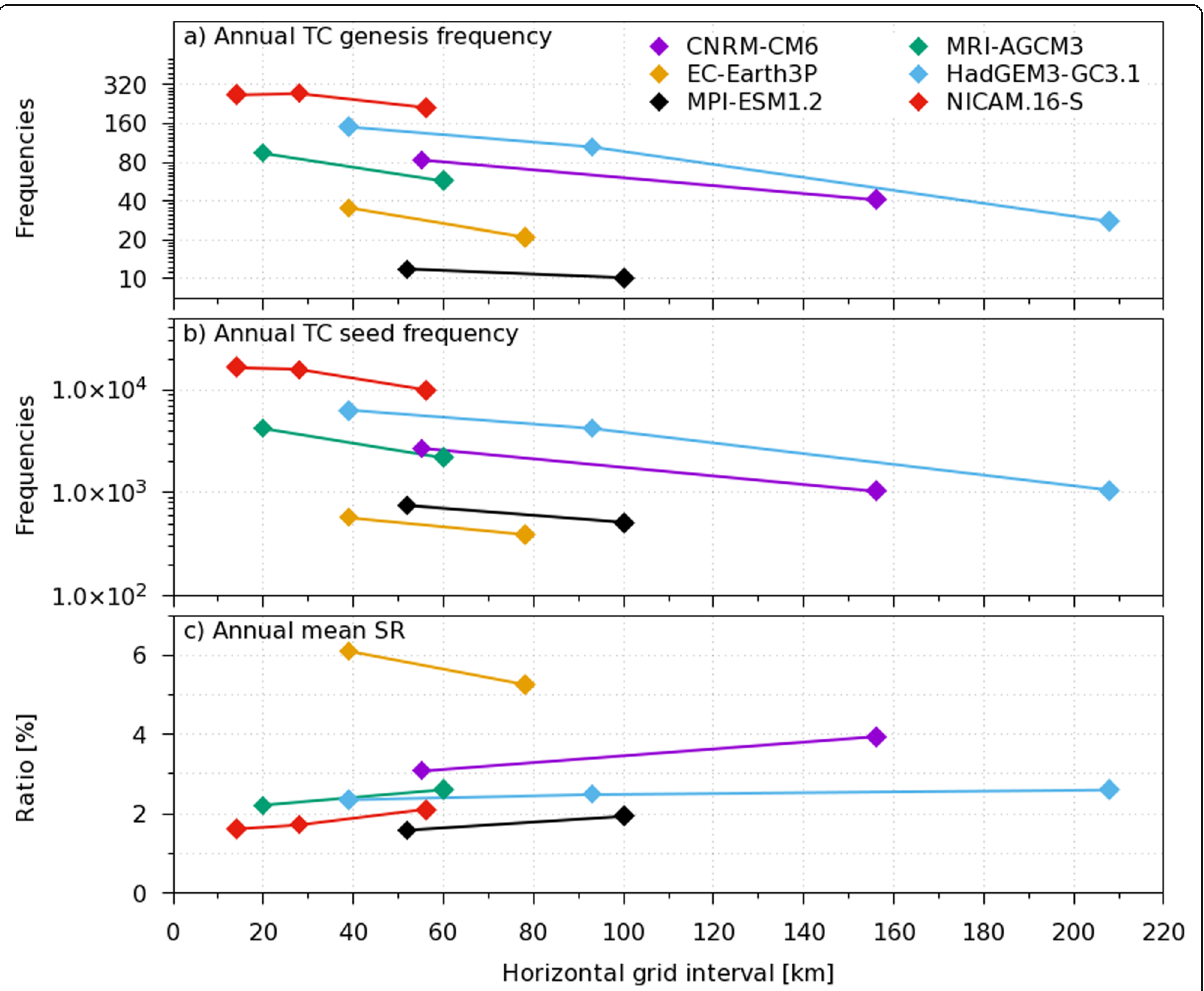
Fig. 7 Scatter plots of TC genesis frequency, TC seed frequency, and SR versus horizontal resolution. Panels show a annual mean TC genesis frequency, b annual mean TC seed frequency, and c annual mean SR, which are sorted by horizontal grid interval ( x -axis). Annual mean value is calculated by averaging a variable from 1990 to 2014. In NCM014, annual mean value is calculated by averaging a variable from 2000 to